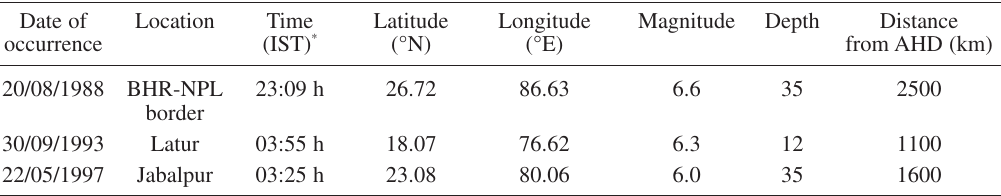
Table I. Details of the three earthquakes